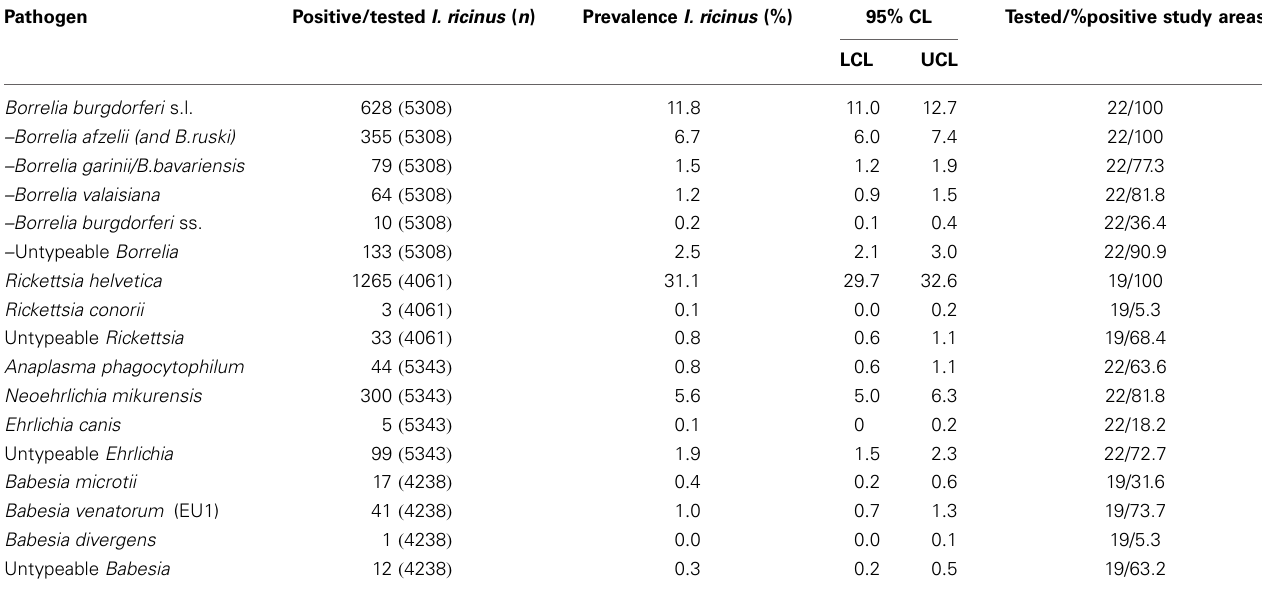
Table 1 | Presence of microorganisms in questing I. ricinus nymphs and adults.